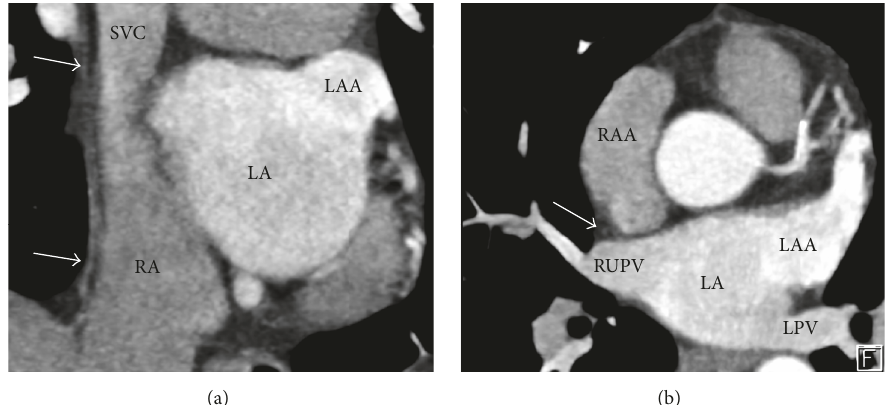
Figure 3: (a) Cardiac MDCT in paracoronal view showing the right pericardiophrenic bundle (arrows) adjacent to the superior vena cava (SVC) and right atrium (RA). (b) Paraxial view demonstrating the close relation (1mm) of the pericardiophrenic bundle (arrow) to the right upper pulmonary vein (RUPV). RA: right atrium, LA: left atrium, LAA: left atrial appendage, RAA: right atrial appendage, and LPV: Left pulmonary